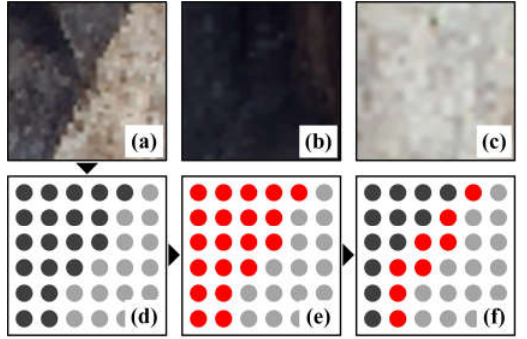
Figure 5. Distribution of the 3D point cloud into voxels. ( a – c ) True color of the 3D point cloud on the surface of a rock mass in the voxels. ( d ) Sketch of the 3D point cloud. ( e ) Dark areas with substantial color changes (the red points). ( f ) Boundary of the dark areas (the red points).